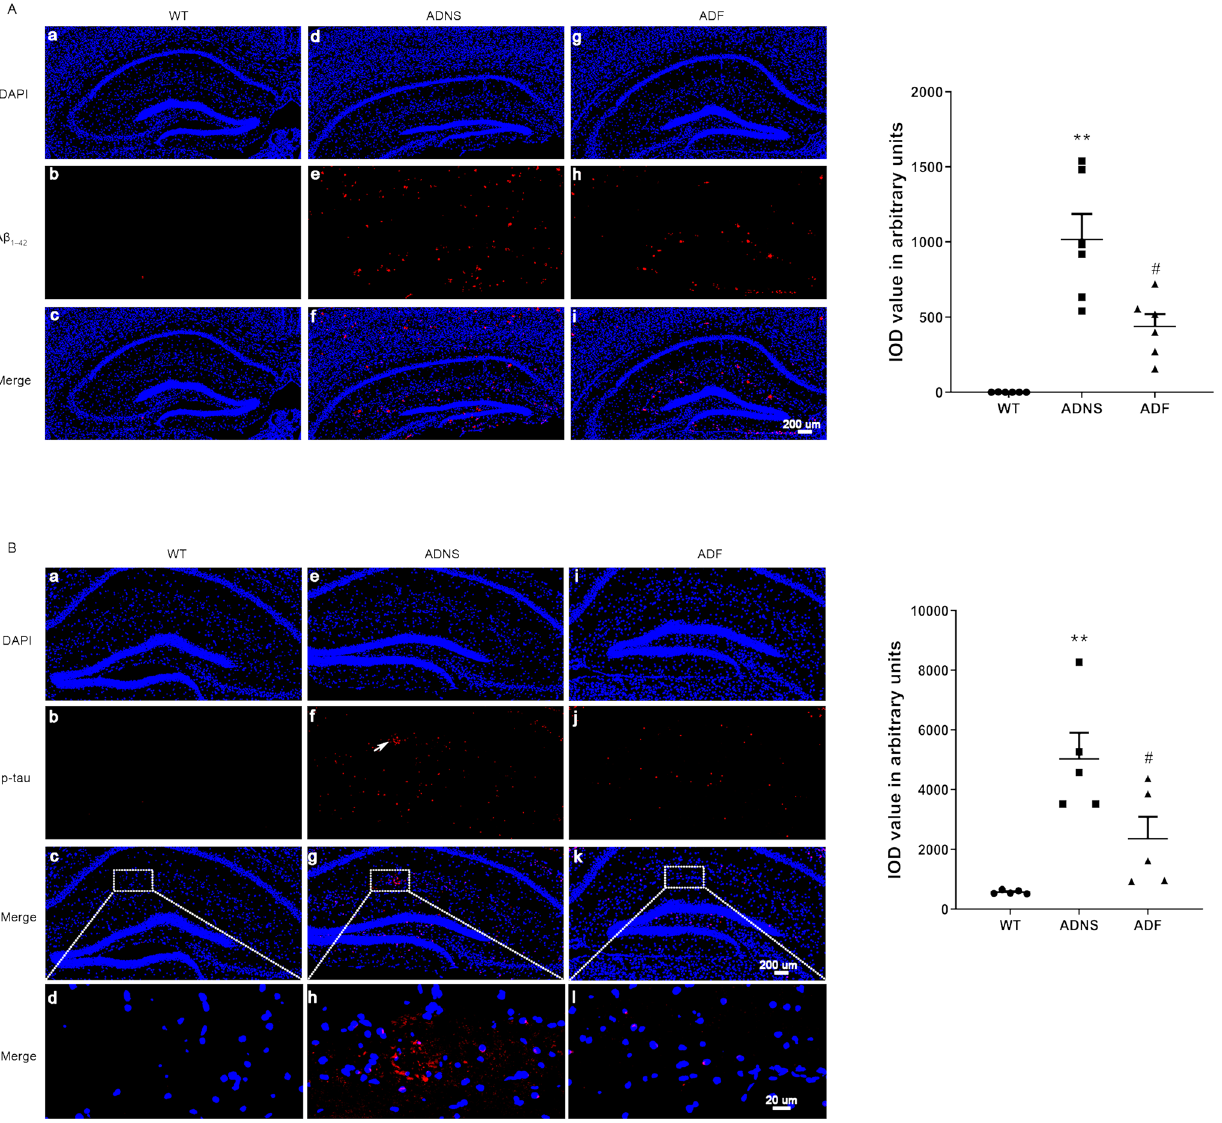
Figure 1. Fasudil treatment reduced Aβ plaque deposition and phosphorylated tau tangles in the hippocampus. ( A ) Aβ 1-42 plaques was checked in the hippocampus of the mice in each group. (a–c) WT, (d–f) ADNS, (g–i) ADF. Immunofluorescent intensity quantification of anti-Aβ 1-42 showed significant increased intensity in ADNS group when compared with WT ( p < 0.01) and the reverse in the Fasudil-treated mice, suggesting the protective effect on Aβ burden and therapeutic potential for clearance of Aβ plaques in AD with Fasudil treatment. (B) Tau phosphorylation at S404 was checked in the hippocampus of the mice in each group. (a–d) WT group, (e–h) ADNS group, (i–l) ADF group. Images (a–c, e–h, i–l) were taken at 10× (200 μm). The box area is enlarged, and the images (d, h, l) were taken at 60× (20 μm). DAPI (blue) was used for nuclei staining. Immunofluorescent intensity quantification of anti-Phospho-Tau (S404) showed a significant increase in intensity in the ADNS group when compared with WT ( p < 0.01); the reverse was observed in the Fasudil-treated mice. Data is presented as Mean ± S.E.M. * p < 0.05, ** p < 0.01 versus WT; # p < 0.05, ## p < 0.01 versus ADNS. The Dunnett’s test were used for statistical